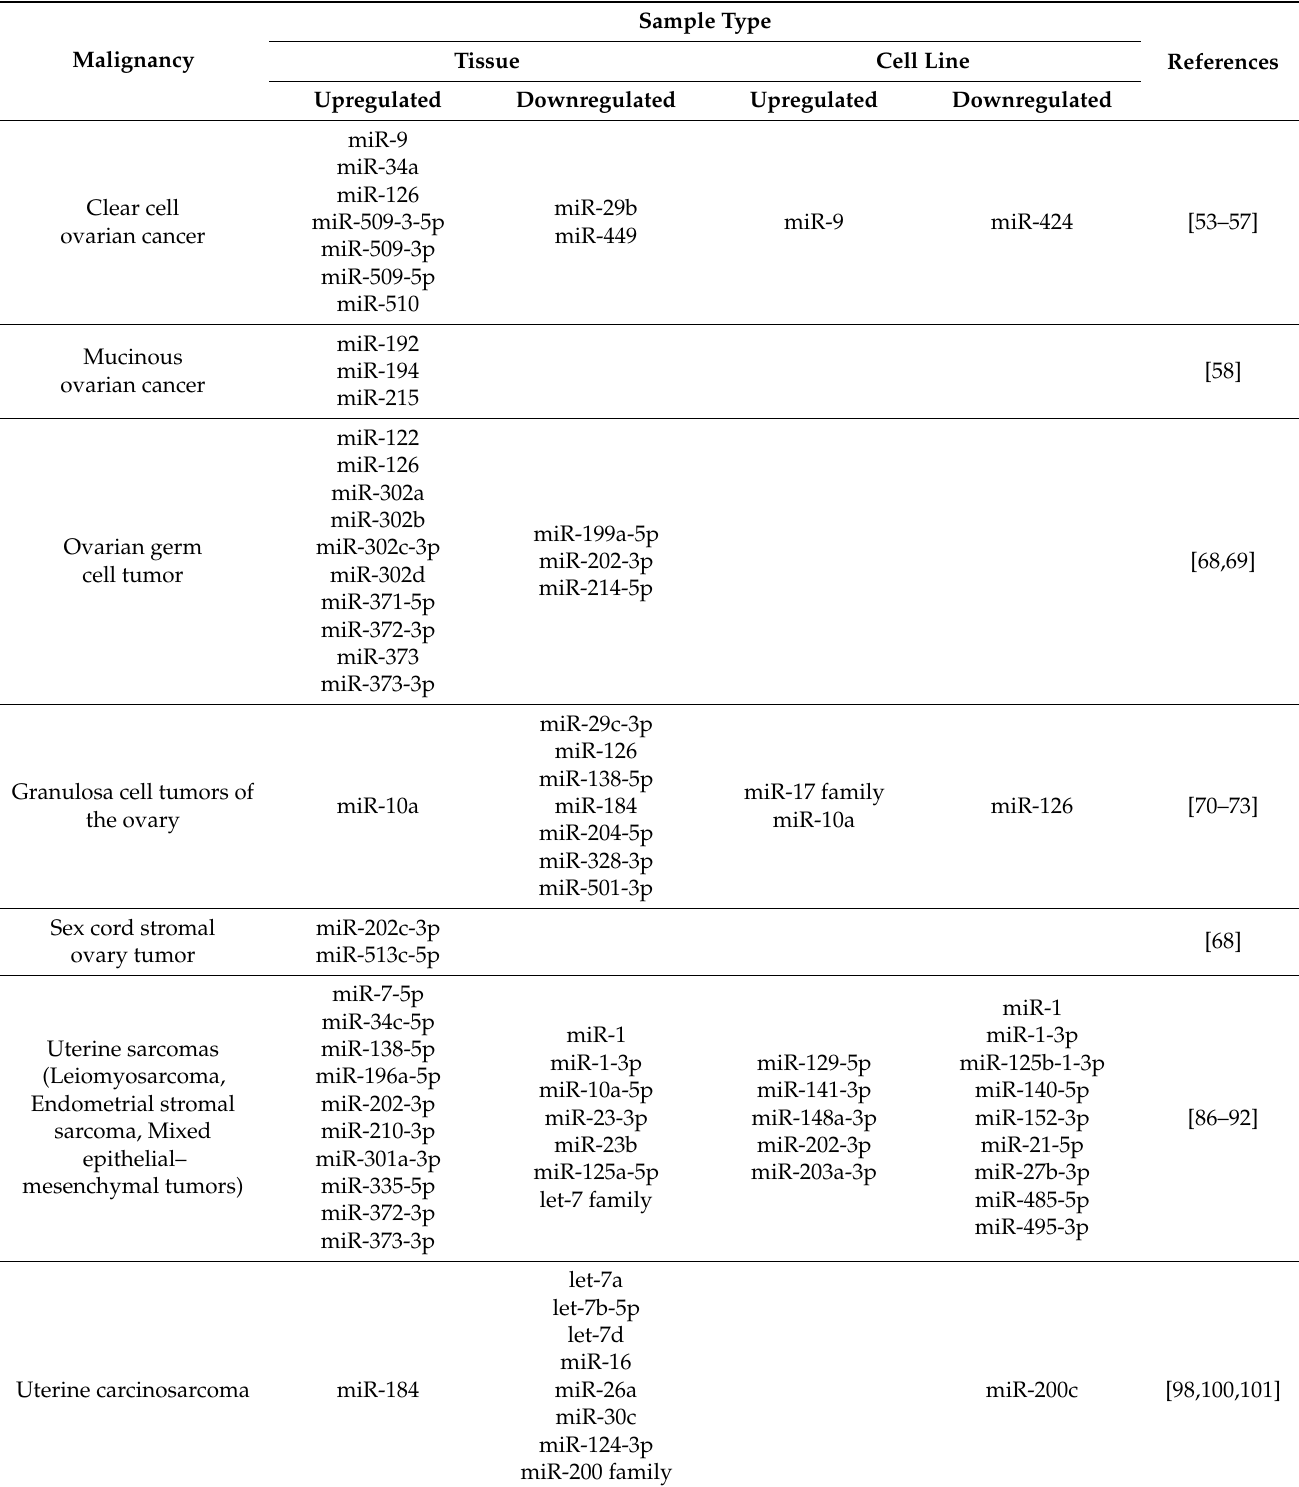
Table 1. List of deregulated miRNAs in rare gynecological